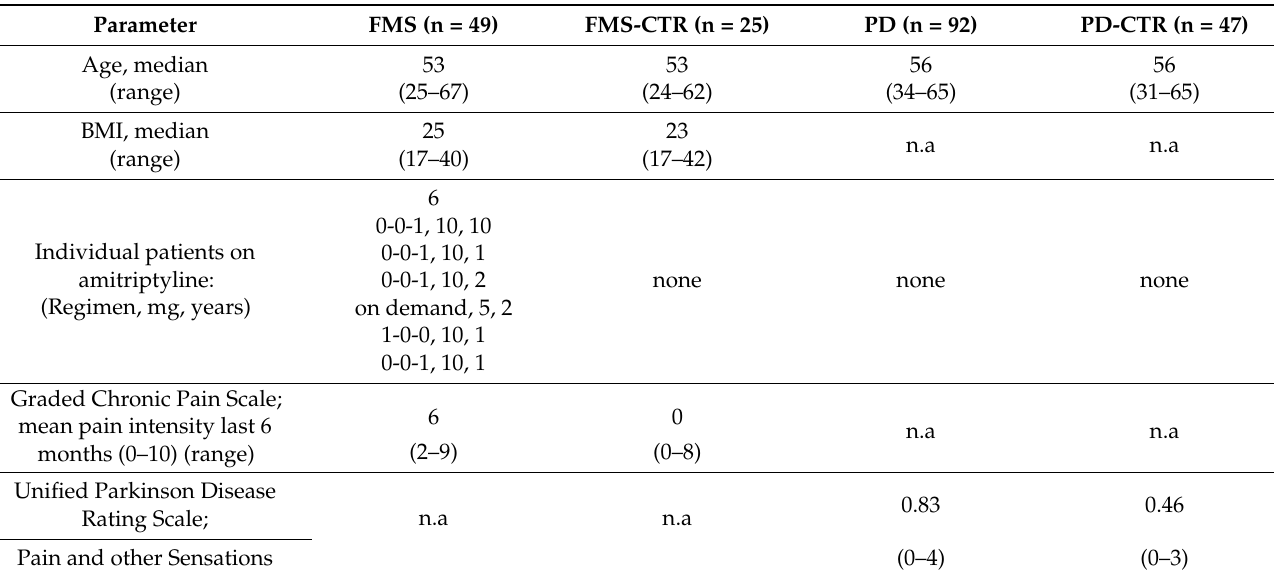
Table 2. Main clinical parameters of the study cohort that was restricted to